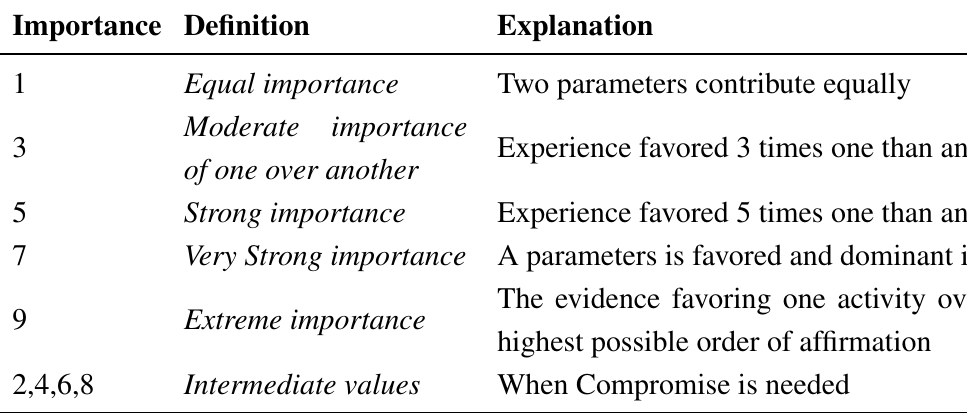
Table 1. The scale of importance [18].